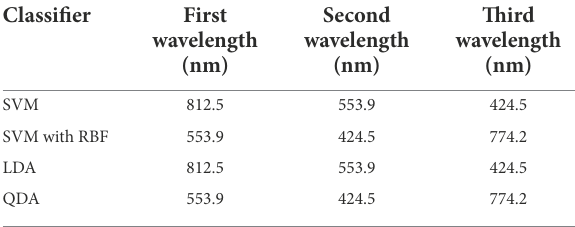
TABLE 3 The three most important wavelengths for each classifier, as determined by the sequential forward selection (SFS) method for selection of